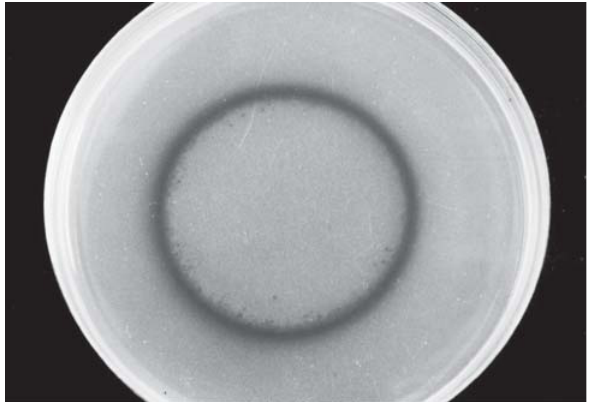
FIGURE 3- Severe genotoxicity of formocresol against strain PQ37 in the SOS